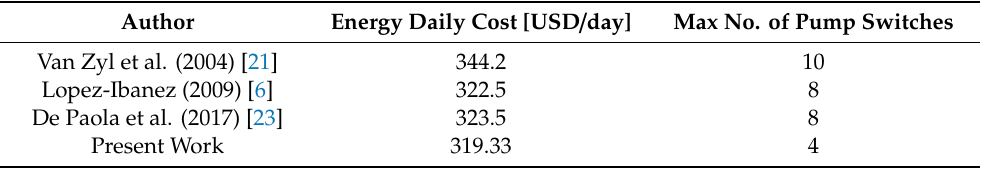
Table 1. Comparison of the best literature solutions for Case 1 with ON / OFF